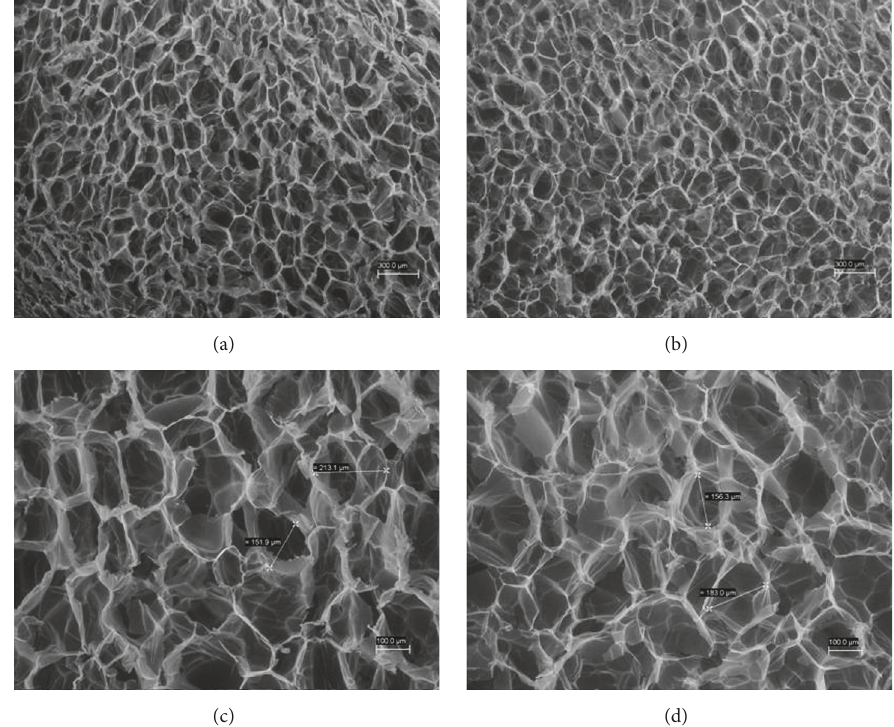
Figure 1: (a) GN1 CS scaffold at 100x magnification in transversal section; (b) GN2 CS scaffold at 100x magnification in transversal section; (c) GN1 CS scaffold at 250x magnification and pore size measurements in transversal section; (d) GN2 CS scaffold at 250x magnification and pore size measurements in transversal section.